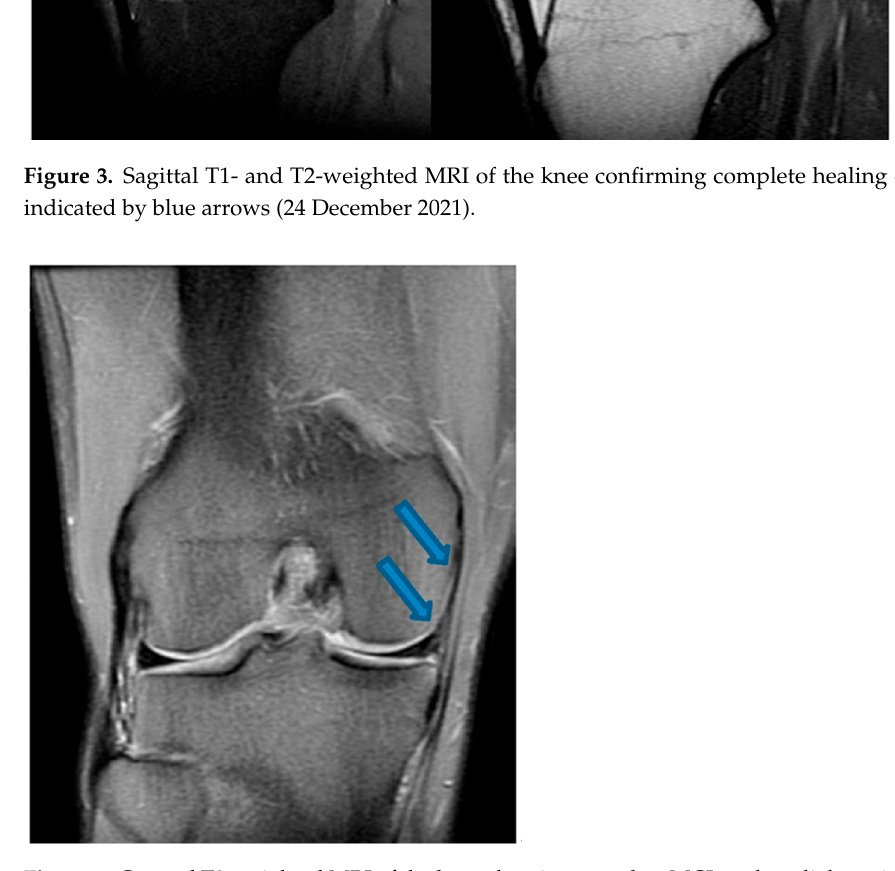
Figure 4. Coronal T2-weighted MRI of the knee showing complete MCL and medial meniscus healing indicated by blue arrows (24 December 2021).